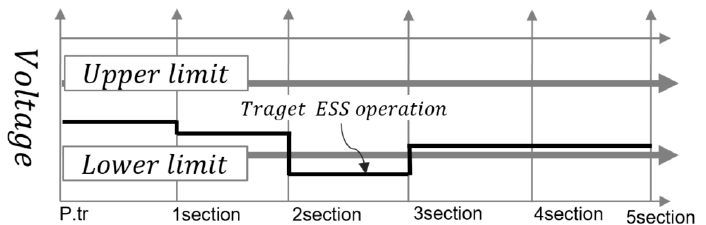
Figure 9. Case of voltage to be violated in only one section.